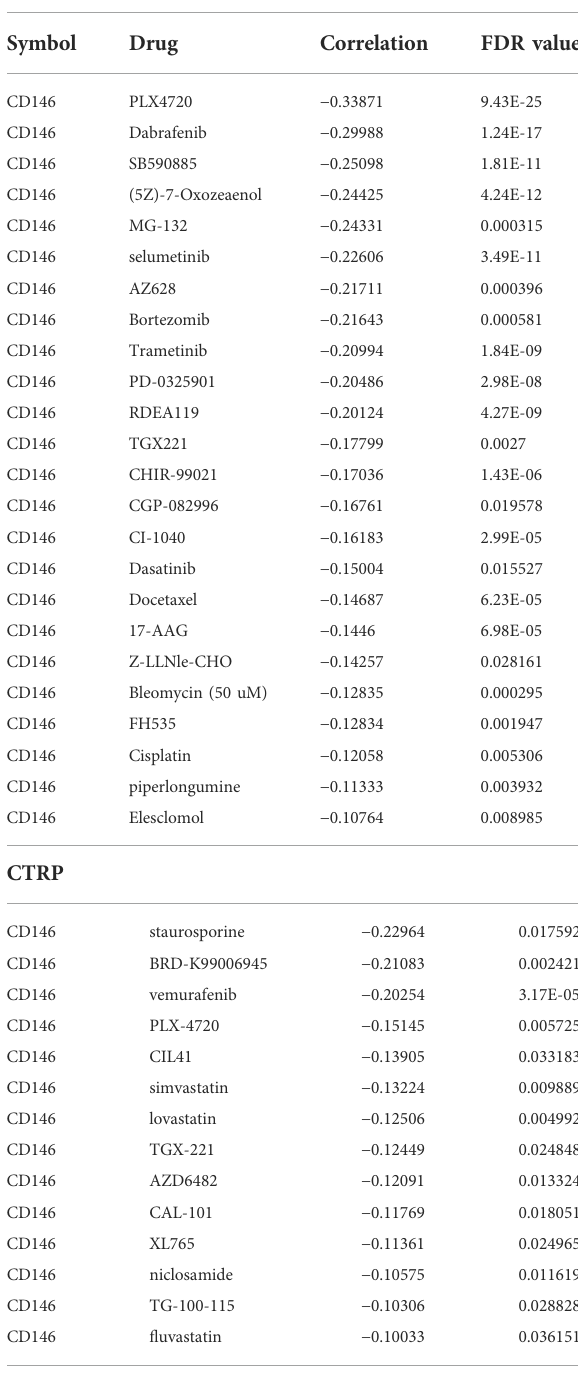
TABLE 2 Prediction of potential drugs for CD146-high